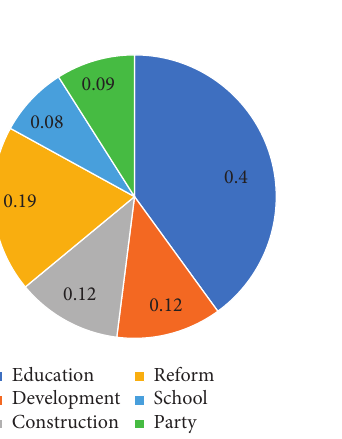
Table 8: Final experimental